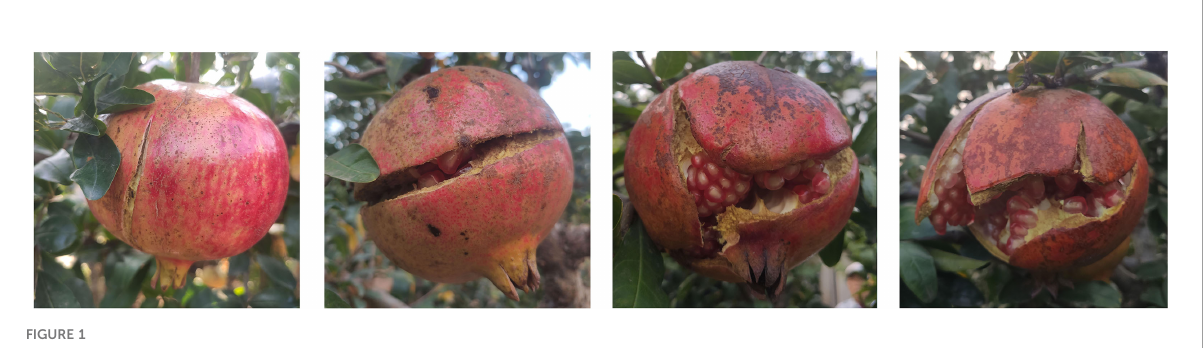
FIGURE 1 Types of fruit